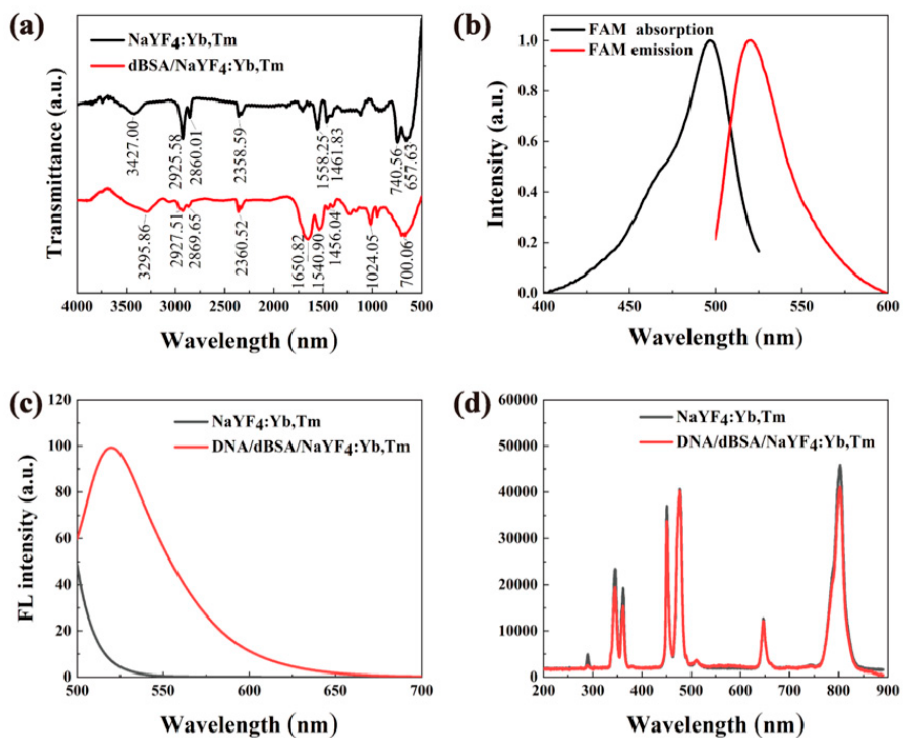
Figure 9. ( a ) Infrared absorption spectra of NaYF 4 : Yb,Tm before and after modification with carboxylated bovine serum albumin. ( b ) Absorption and emission spectra of the FAM fluorophore. ( c ) Fluorescence spectra of NaYF 4 :Yb,Tm and novel fluorescent probes under excitation at 480 nm. ( d ) Fluorescence spectra of NaYF 4 :Yb,Tm and novel fluorescent probes under excitation at 980 nm.